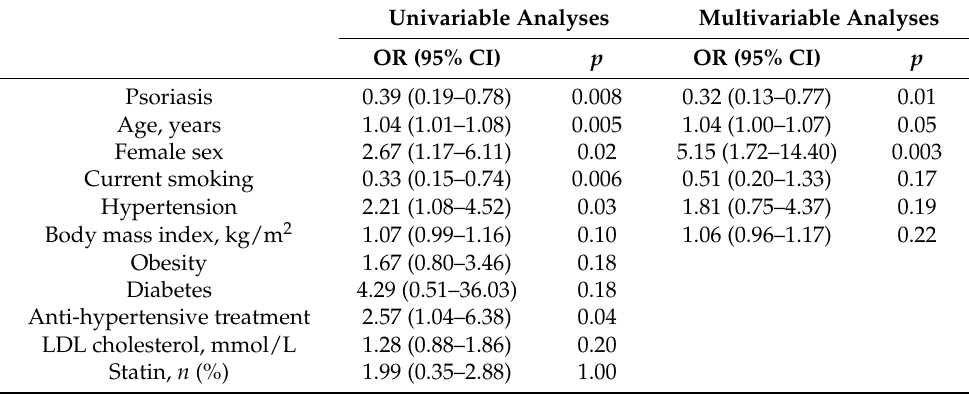
Table 3. Associations of subclinical cardiac organ damage in the total study cohort. Univariable Analyses